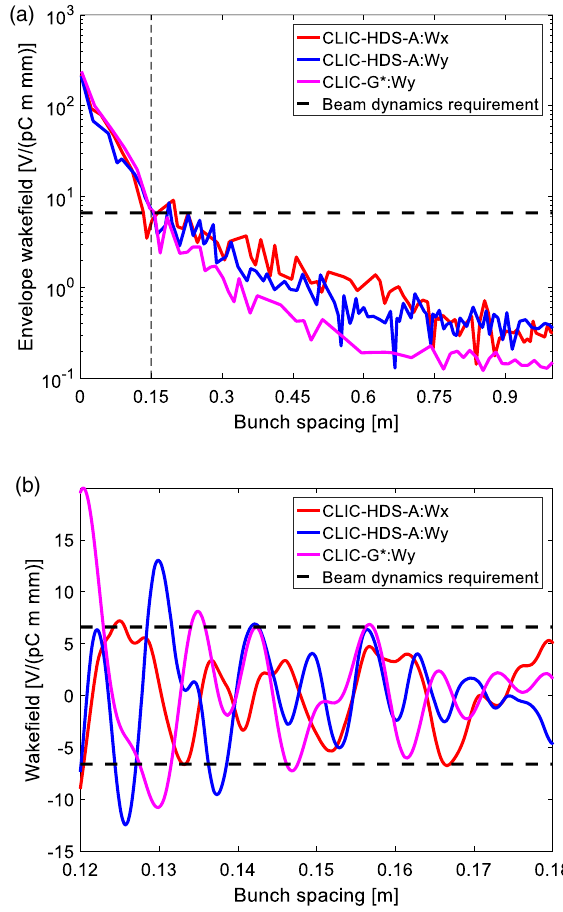
FIG. 17. Wakefield simulation results of CLIC-HDS-A: (a) Enveloped wake in log scale; (b) wake in linear